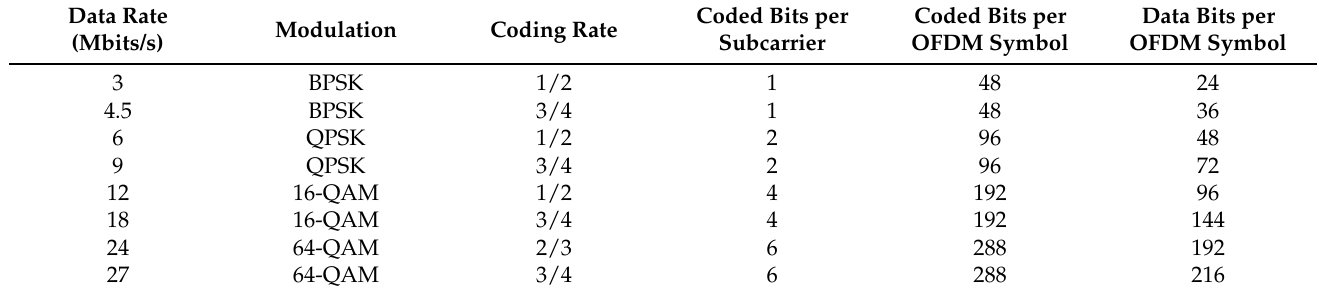
Table 2. Transmission mode of OFDM signal according to the data rate in IEEE